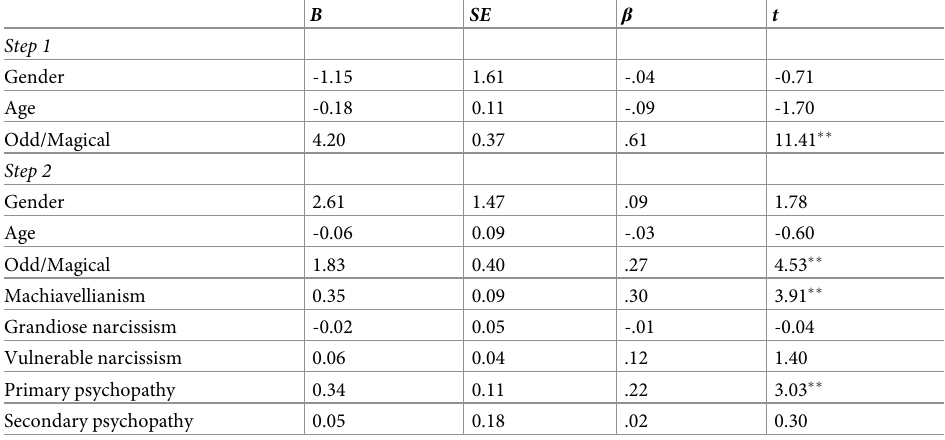
Table 3. Coefficients for predictors of Machiavellianism, grandiose narcissism, vulnerable narcissism, primary psychopathy, secondary psychopathy, and odd beliefs/magical thinking . B SE